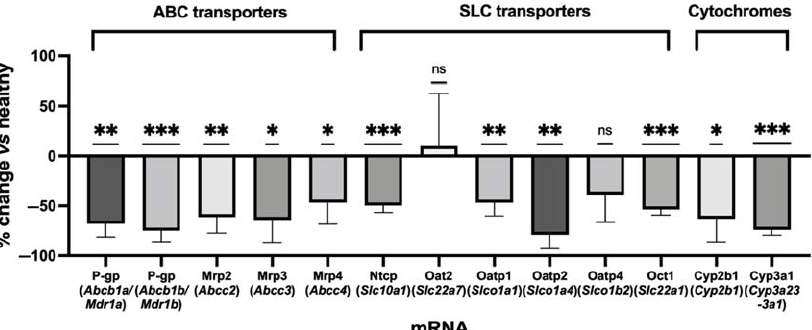
Figure 2. Changes in transporter and cytochrome mRNA expression in the liver of LPS-treated rats (24 h after exposure to LPS) compared to healthy rats estimated by qPCR ( n = 4 both in healthy and LPS-treated groups). Data are mean ± SD. * p ≤ 0.05, ** p ≤ 0.01, *** p ≤ 0.001, ns indicates not significant, one-sample t -test after a Shapiro–Wilk Normality test. Cyp: cytochrome; LPS: lipopolysaccharide; Mdr: multidrug resistance; Mrp: multidrug-resistance associated protein; Ntcp: Na+-taurocholate cotransporting polypeptide; Oat: organic anion transporter; Oatp: organic anion- transporting polypeptide; Oct: organic cation transporter.